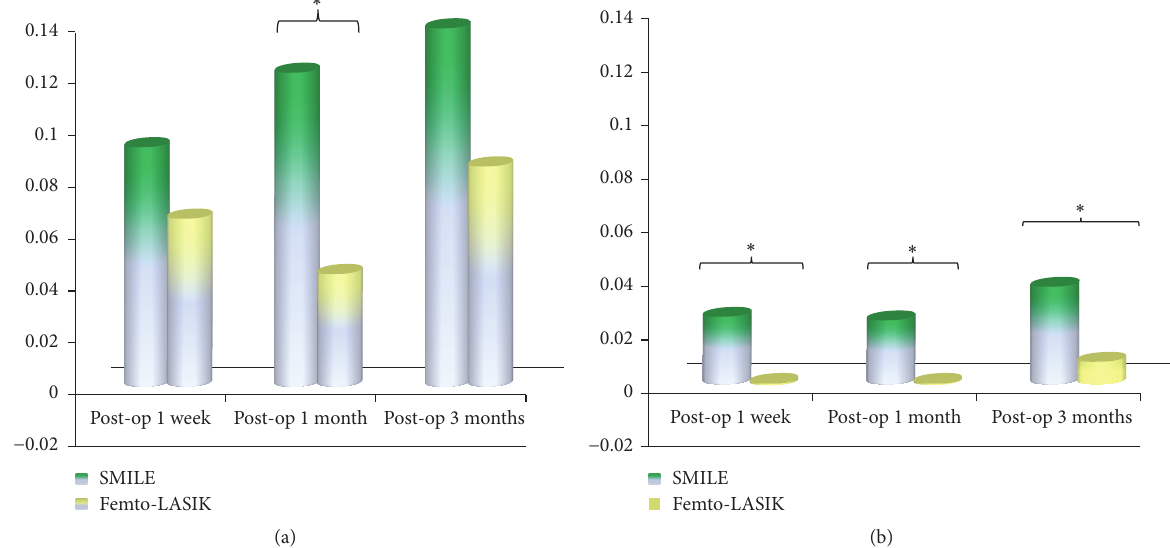
Figure 6: Changes in Δ Strehl ratio values between SMILE and Femto-LASIK procedures ((a) 3 mm pupil diameter, (b) 6 mm pupil diameter). ∗ Significant differences ( 𝑃 < 0.05 ) in Δ Strehl ratio values between SMILE and Femto-LASIK